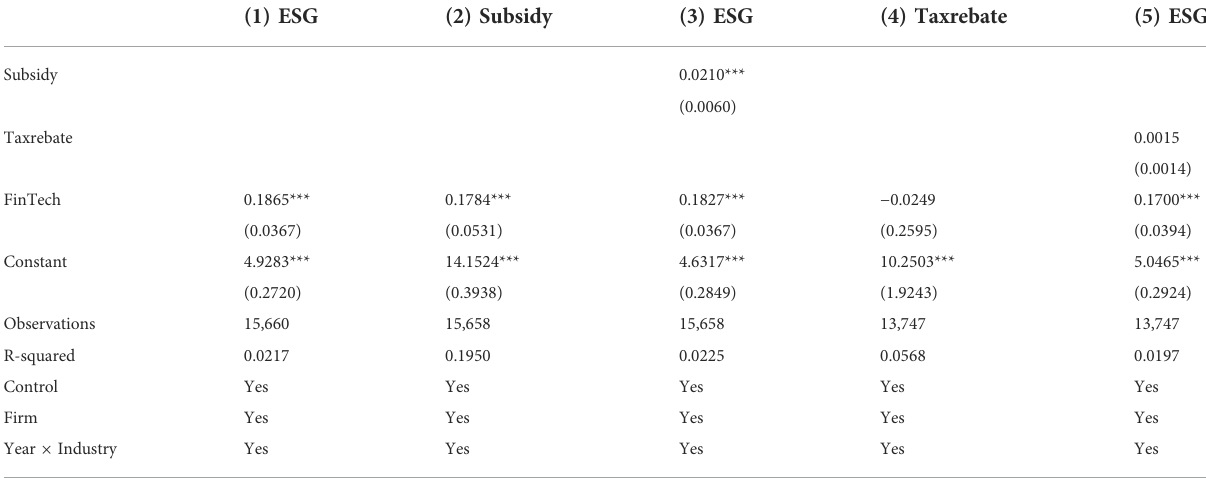
TABLE 8 Mechanism test based on government fi nancial